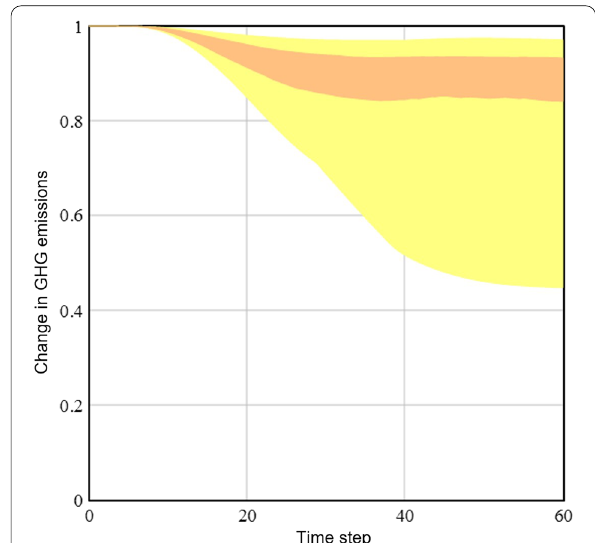
Figure 6 makes the same set of interventions but sam- ples all weights randomly between the minimum and maximum (using Latin hypercube sampling over 200 repetitions). The method assumes that all parameter values within their respective ranges are equally likely.